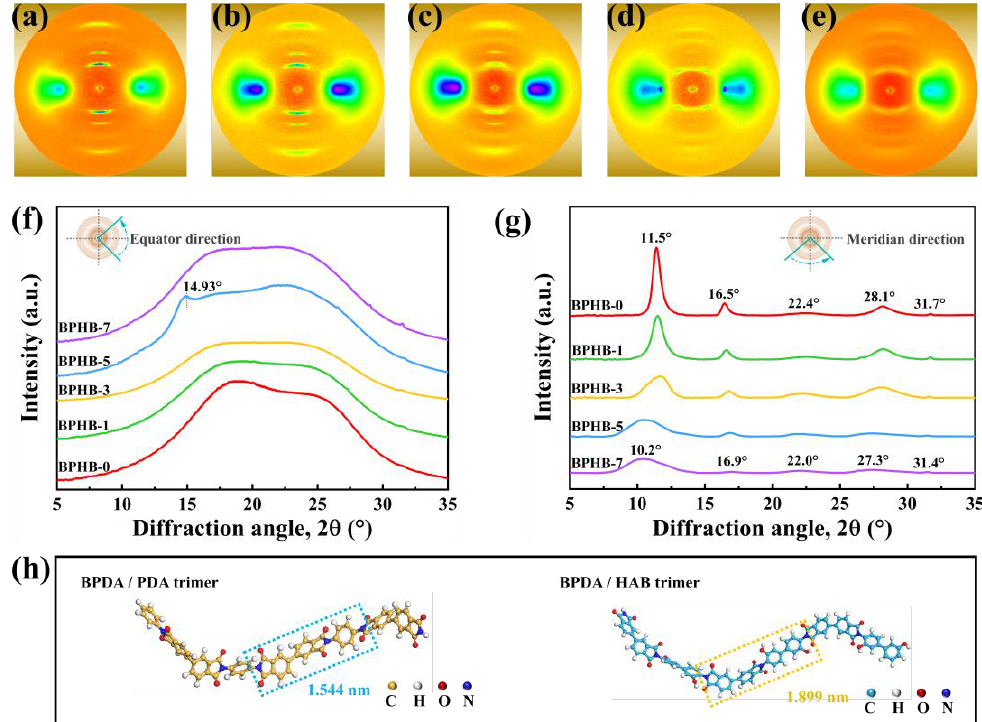
Figure 2. ( a – e ) 2D WAXD patterns for BPHB fibers with p -PDA/HAB/BIA molar ratios of 7/0/3, 6/1/3, 4/3/3, 2/5/3, and 0/7/3, respectively. ( f ) Equator and ( g ) meridian directions of the 1D WAXD profiles for the PI fibers with different p -PDA/HAB/BIA molar ratios. ( h ) Simulated conformations of BPDA/ p -PDA and BPDA/HAB trimers, as well as the length of its repeat units, calculated by using the COMPASS force field of Materials Studio 8.0.